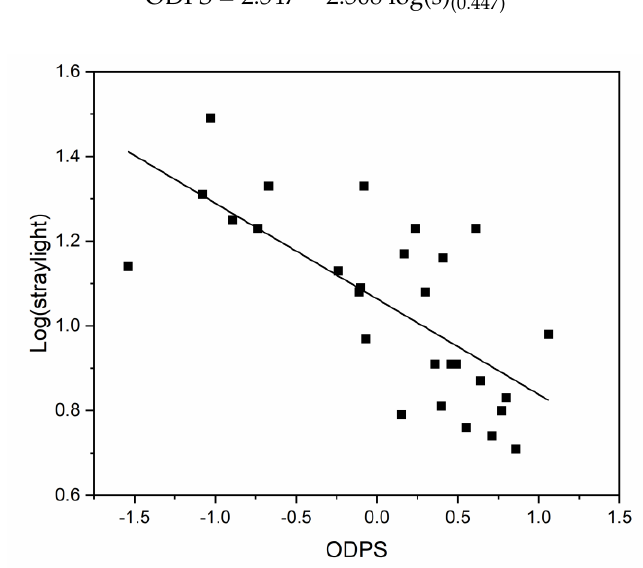
Figure 1. Scatterplot of overall driving performance score (ODPS) and the visual parameter selected as a predictor using the regression model (log(s)).